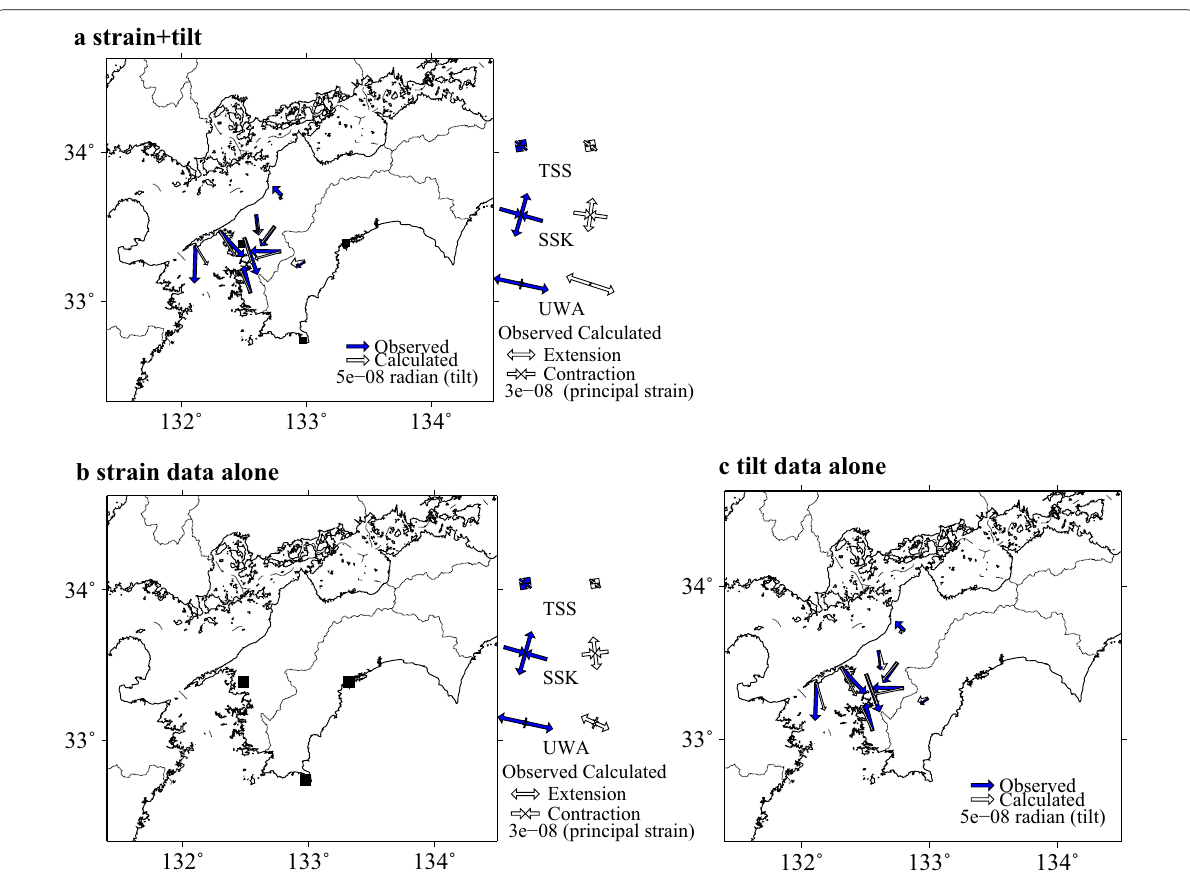
Fig. 19 Observed and calculated strain (right panel) and tilt (left panel) data 23–27 October 2016. Map region corresponds to Area C in Fig. 1. a Strain data and tilt data from observations (blue) and calculated from the estimated slip distribution shown in Fig. 17a (white). b Strain data from observations (blue) and calculated from the estimated slip shown in Fig. 17b (white). c Tilt data from observations (blue) and calculated from the estimated slip distribution shown in Fig. 17c